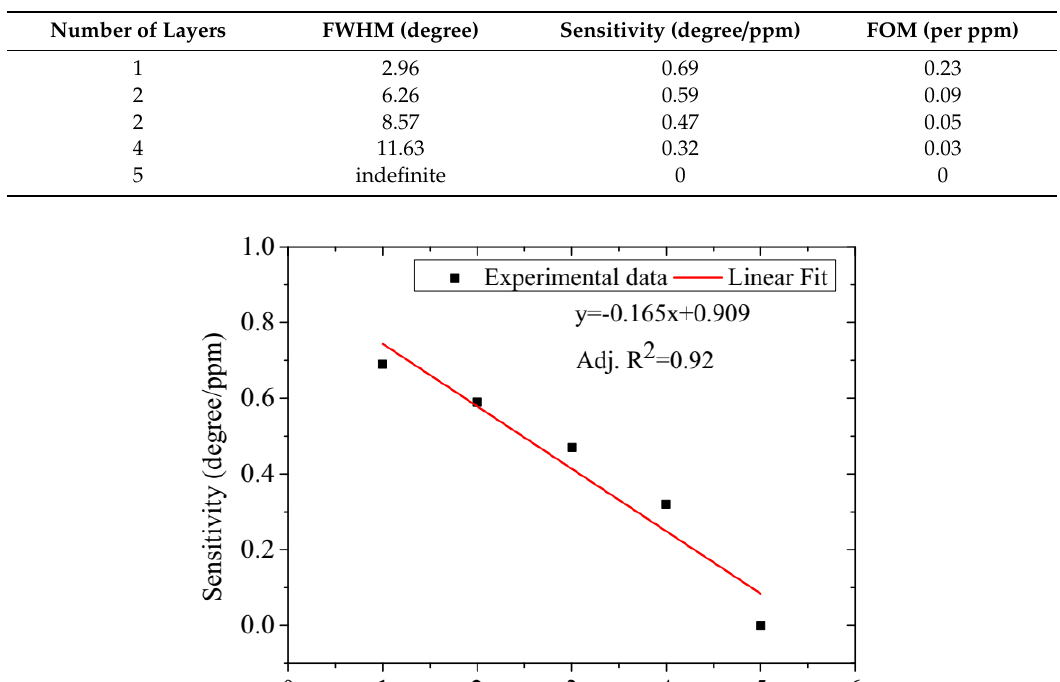
Table 3. Performance characteristics of ternary SPR acetone vapour sensor based on 1, 2, 3, 4, and 5 layers of the ternary composite film.